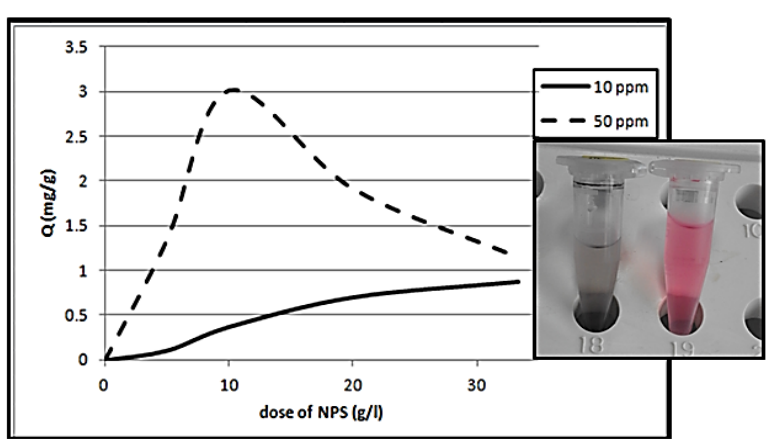
Figure 10. Impact of CR initial concentration on the adsorption values (at different adsorbent doses;